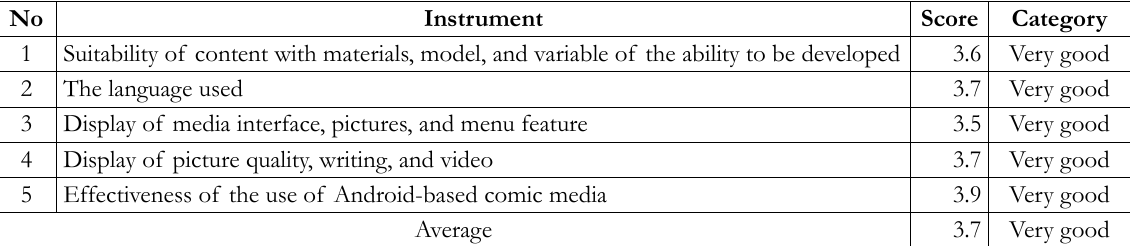
Table 8. Result of feasibility evaluation of android-based comic